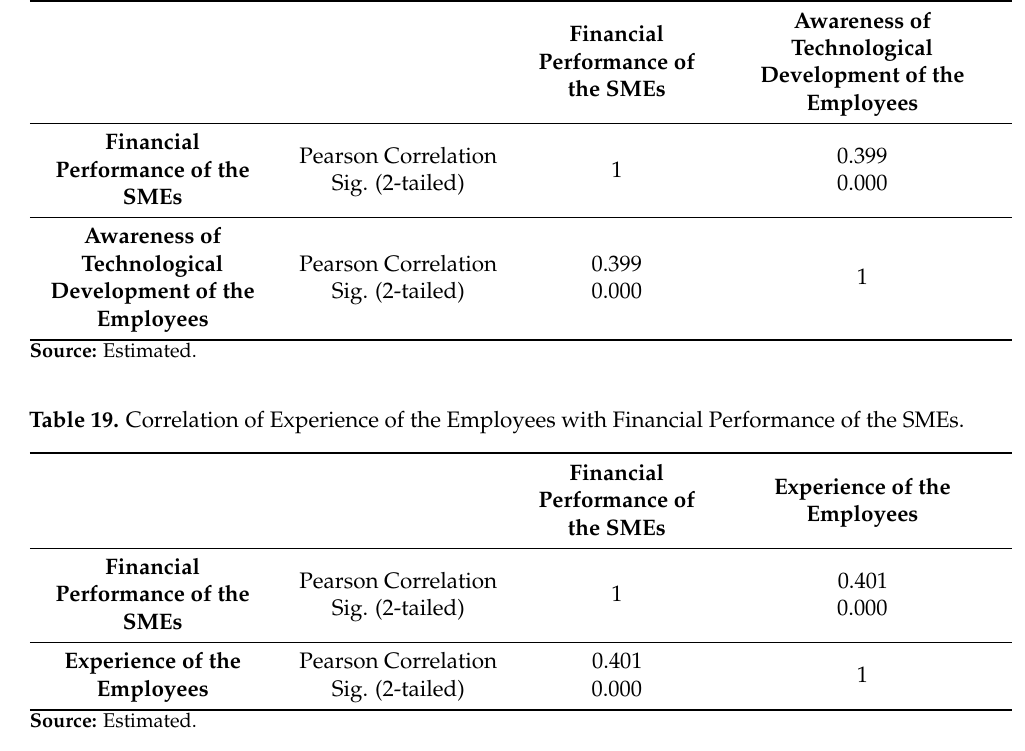
Table 18. Correlation of Awareness of Technological Development of the Employees with Financial Performance of the SMEs.